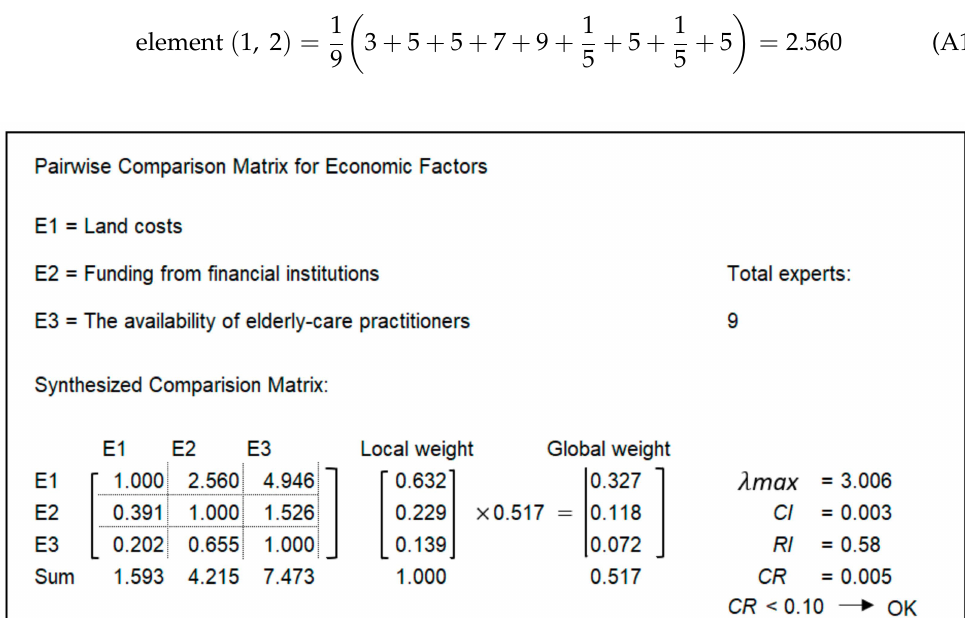
Figure A2. An example of weights